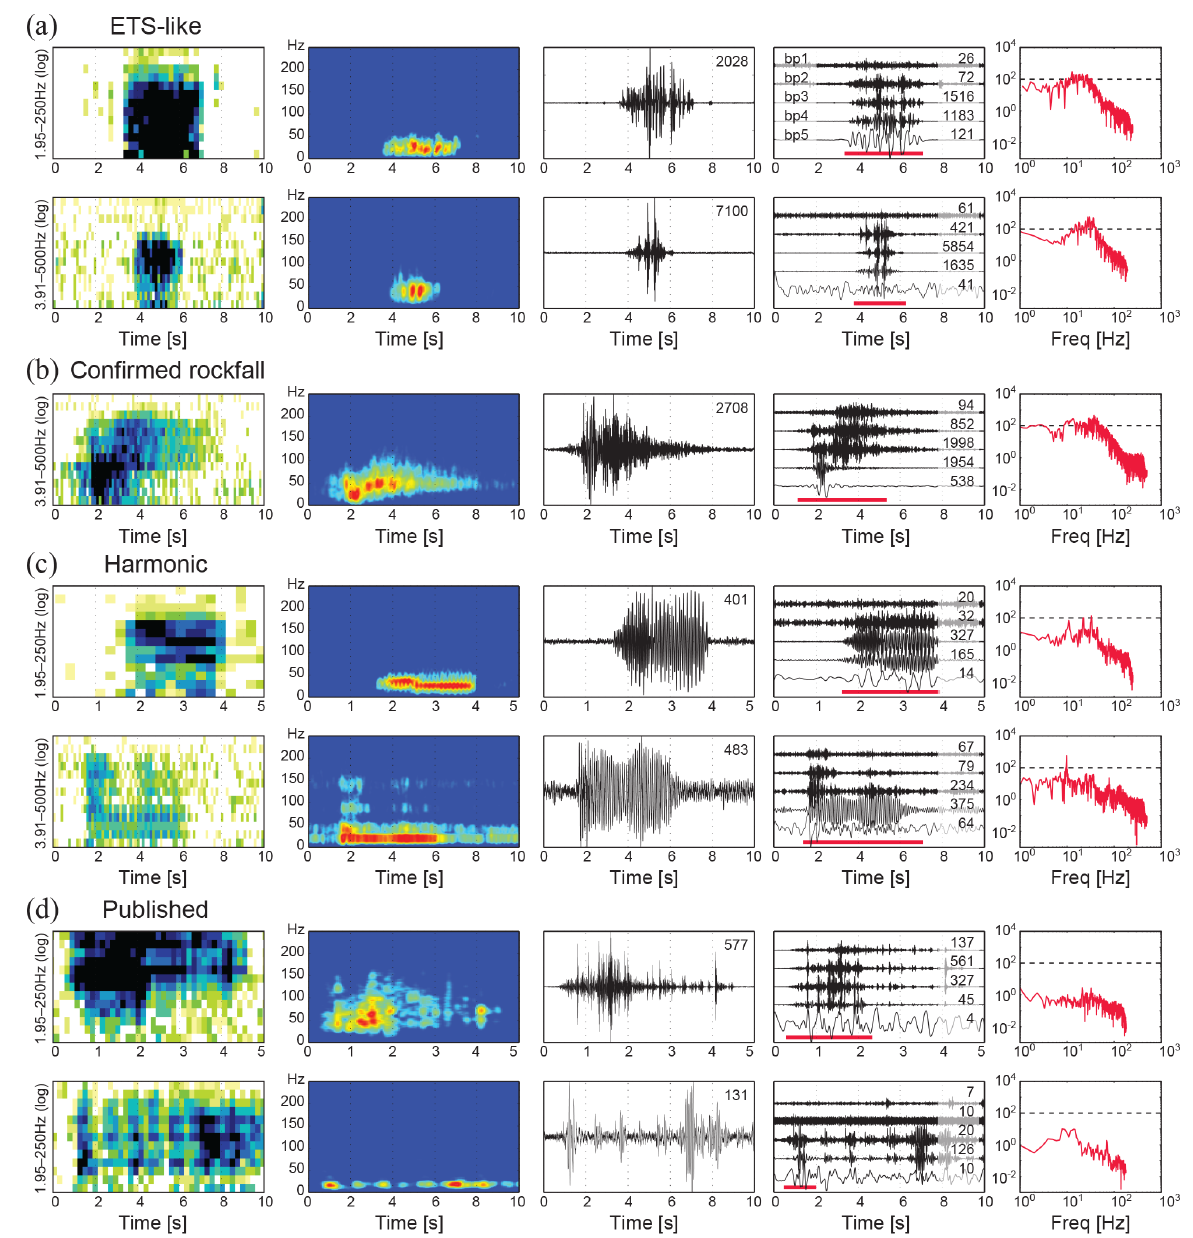
Figure 6. Seismic features of moderate duration ( < 20s) tremor signals recorded at Super-Sauze and Pechgraben. (a) ETS-like events. Top: PG15, S2.4, t 0 10 October 2015, 00:37:50. Bottom: SZ10, S3.4, t 0 5 June 2010, 15:26:35. (b) Confirmed rockfall event at source–receiver distance of 29m (Rothmund et al., 2017), SZ10, S2.5, t 0 4 June 2010, 06:45:20. (c) Harmonic tremors. Top: PG15, S2.6, t 0 10 Octo- ber 2015, 00:36:26. Bottom: SZ10, S2.3, t 0 4 June 2010, 20:07:28. (d) Published tremor signals by Walter et al. (2012). Top: fissure event, t 0 14 July 2008, 23:48:40. Bottom: rockfall event, t 0 14 July 2008,